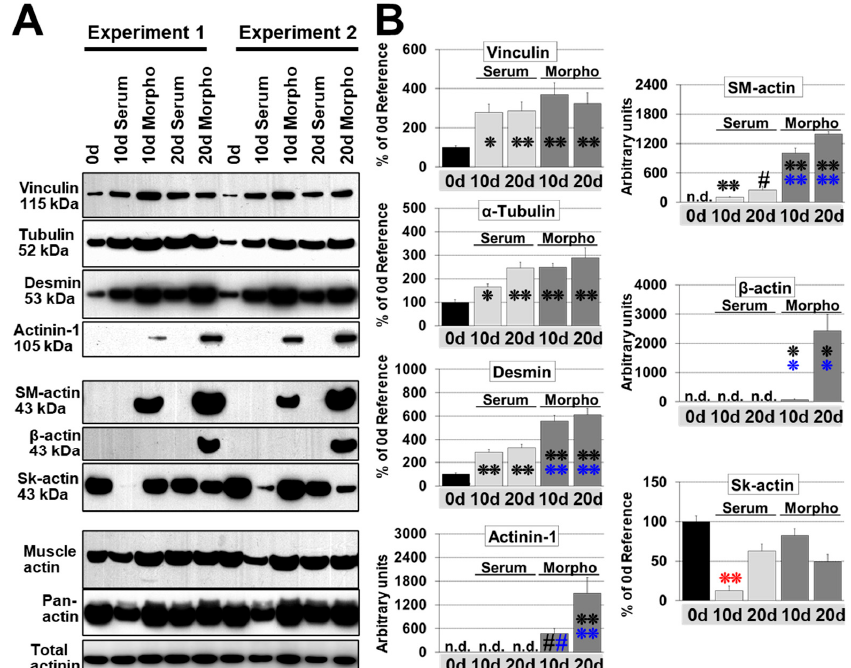
Figure 1. Fetal but not hypertrophic remodeling leads to the reexpression of fetal genes. Primary cultures of adult cardiomyocytes were harvested at the start of the experiment (0 d, reference), after 10 (10 d), and 20 days (20 d) for western blot analysis. Zero-day cultures reflect the protein composition of cardiomyocytes in the normal adult heart. Cultures were stimulated with 5% serum (Serum) and conditioned supernatant of cardiac microvascular endothelial cells containing no growth supplements (Morpho, 80%). ( A ) Total protein (10 µg) were analyzed for the expression of vinculin, α -tubulin (Tubulin), desmin, skeletal actin (Skel-actin), and the reexpression of α -actinin-1 (Actinin-1), β -actin and α -smooth muscle actin (SM-actin). Muscle actin and pan-actin served as loading controls. Detected molecular sizes are indicated. ( B ) Quantitative evaluation and statistical analysis of ( A ). Note that the order of groups is presented di ff erently from ( A ). Single and double stars indicate p < 0.01 and p < 0.001, respectively. Hash signs indicate p < 0.05. Black signs refer statistically to Con 0 d, blue signs to serum, and the red to all other